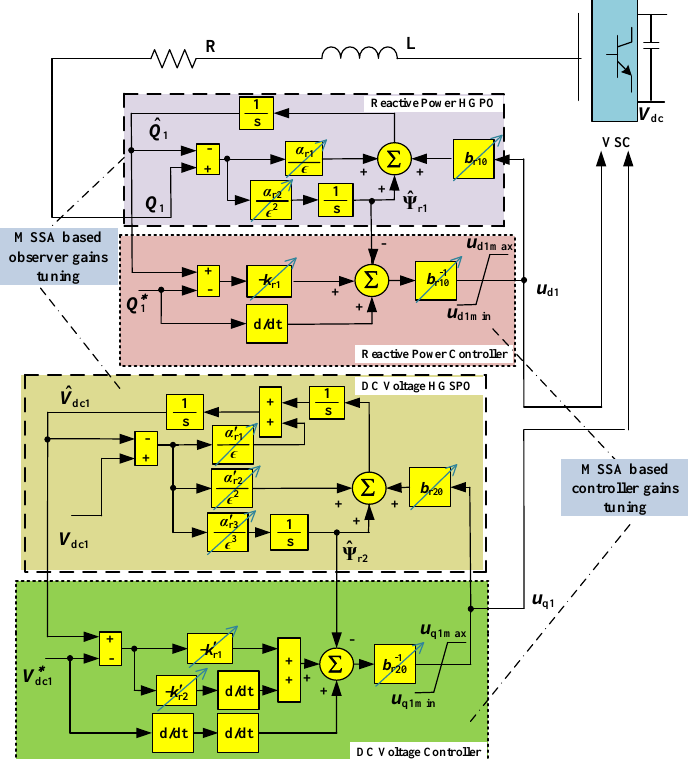
Figure 3. The overall optimal nonlinear adaptive control (ONAC)-based control framework of rectifier.